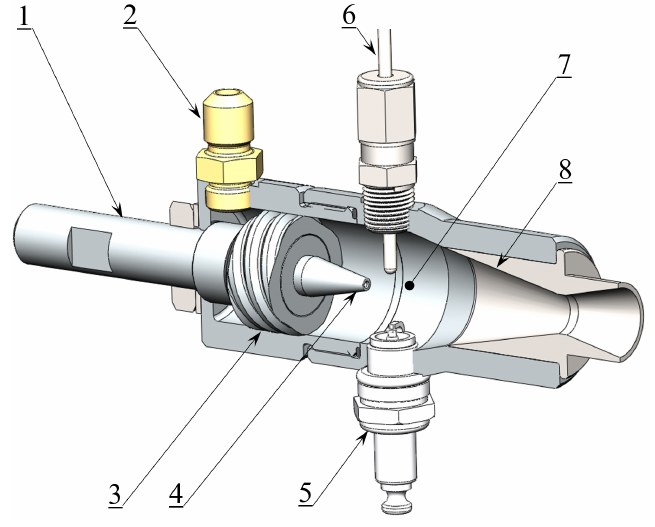
Figure 1. The igniter assembly: 1—methane inlet, 2—oxygen inlet, 3—oxygen swirl injector, 4— conical jet injector, 5—spark plug, 6—thermocouple, 7—combustion chamber, 8—nozzle. Once the flame is detected, the ignition system increases the propellants’ mass flow rates providing necessary energy output to the rocket motor during the ignition